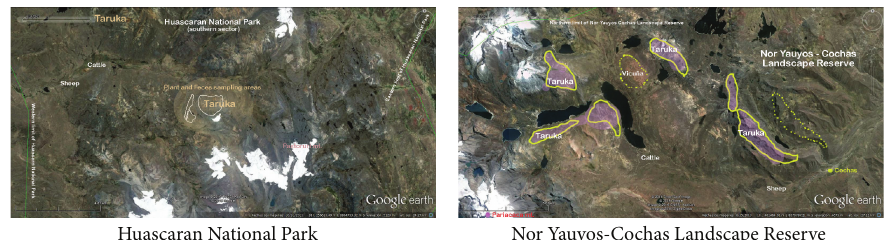
Figure 1: Map of research areas. Buff shadowed area in Huascaran National Park and light pink shadowed areas in Nor Yauyos-Cochas Landscape Reserve are the areas where plant and feces were collected.